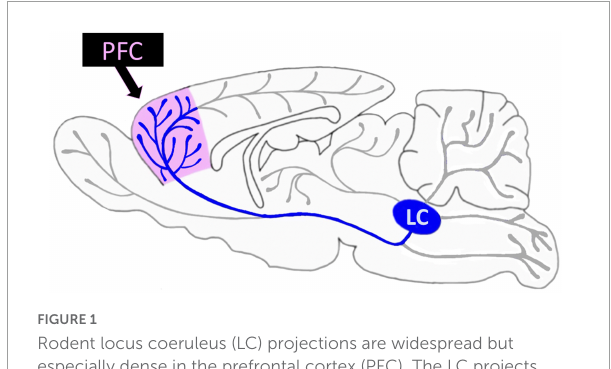
FIGURE1 Rodent locus coeruleus (LC) projections are widespread but especially dense in the prefrontal cortex (PFC). The LC projects widely across the rodent brain (gray) including the PFC (pink); LC-PFC projections are particularly dense (blue) compared to other LC projections.